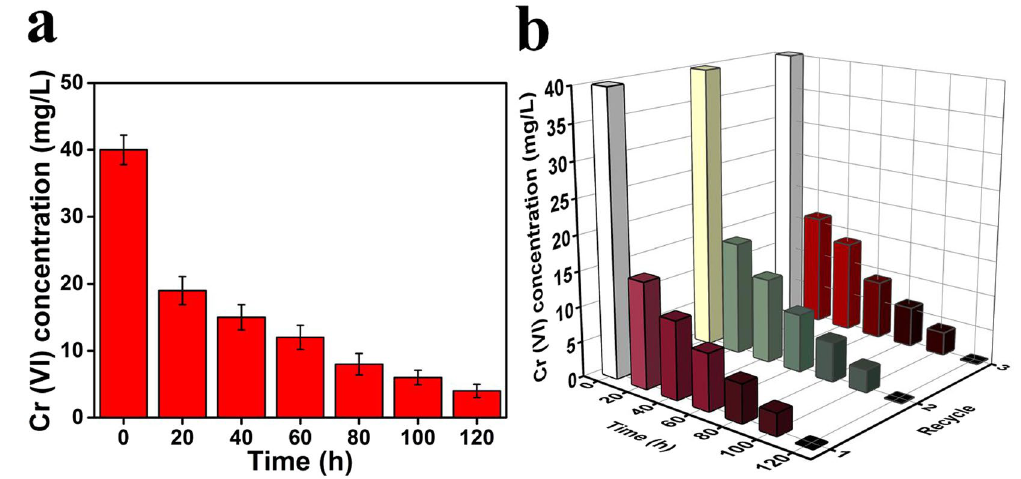
Figure 10. The biodegradation process of free B . subtilis ( a ) and B . subtilis packed into CM@PGO with cycling performance ( b ) (the weight of B . subtilis = 2.0 g, Cr (VI) solution volume = 50 mL, T = 30